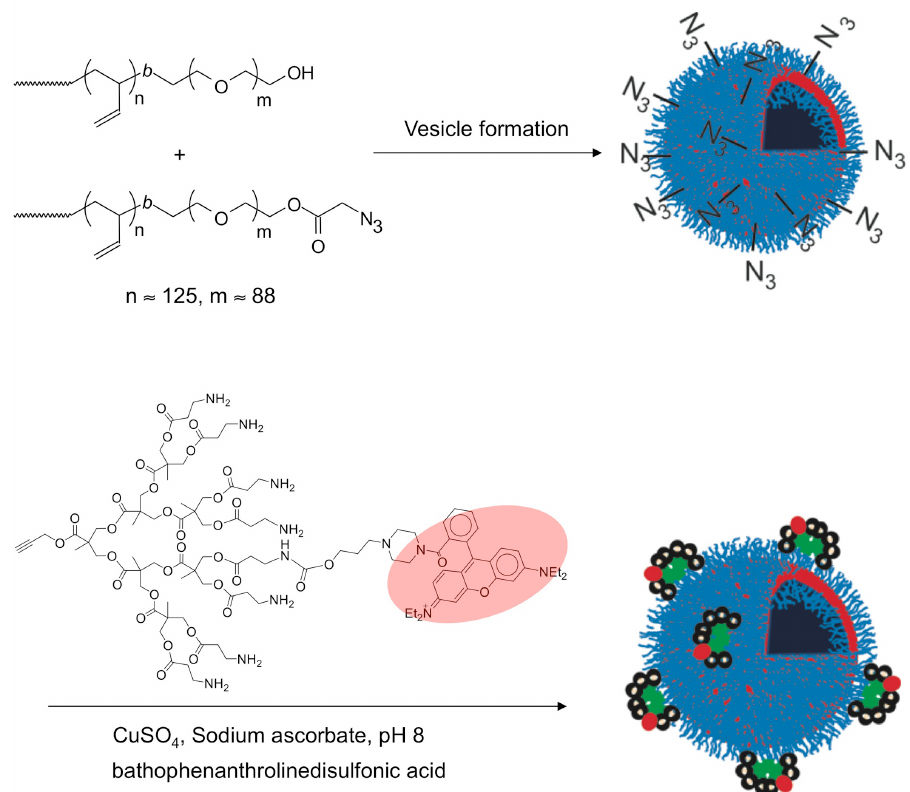
FIGURE 5 - Schematic showing the functionalization of polymersomes bearing peripheral azide groups with dendrons having focal point